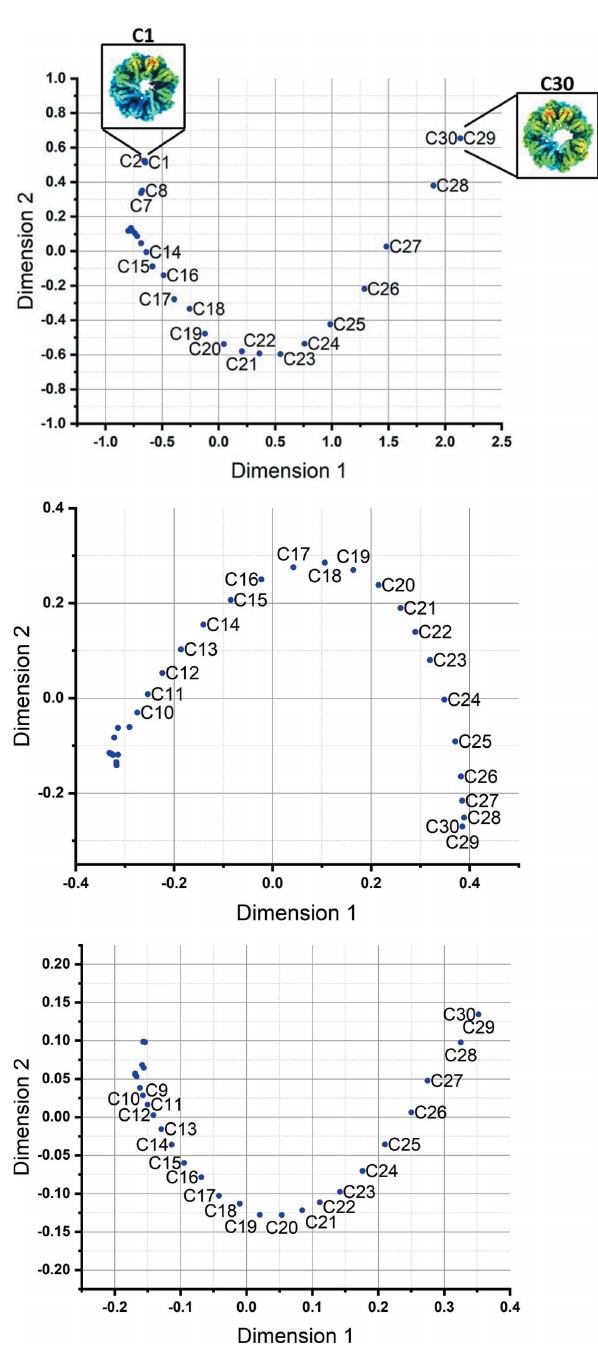
Figure 3 Structure maps of a set of 30 models obtained by an NMA-based approach called adaptive ANM over an open–closed transition of the chaperonin CCT from our previous study (Zhang et al. , 2021 b ) using (top) the deformation distance d 1 , (middle) the correlation distance d 2 and (bottom) the minimum entropy consensus followed by an MDS analysis of the corresponding distance matrices. The open conformation is labelled as C30 and the closed one is C1. The intermediates predicted along low-frequency modes starting from the open state are labelled C29, C28 etc. , whereas the vicinity of C1 populates conformers reached by high-frequency modes. The latter is relatively more sensitive to the metric used in the Zernike3D -based evaluation (compare d 1 in the top panel and d 2 in the middle panel). The consensus path (bottom) provides an optimal solution based on the convex combination of the structure mappings shown in the top and middle plots in such a way that the entropy of the final mapping is